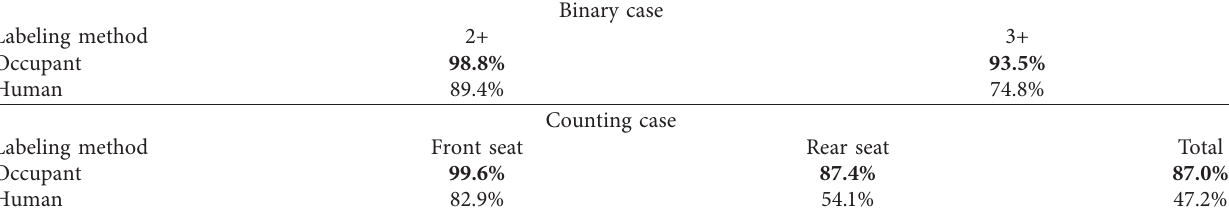
Table 2: Detection accuracy for both models using one image Binary